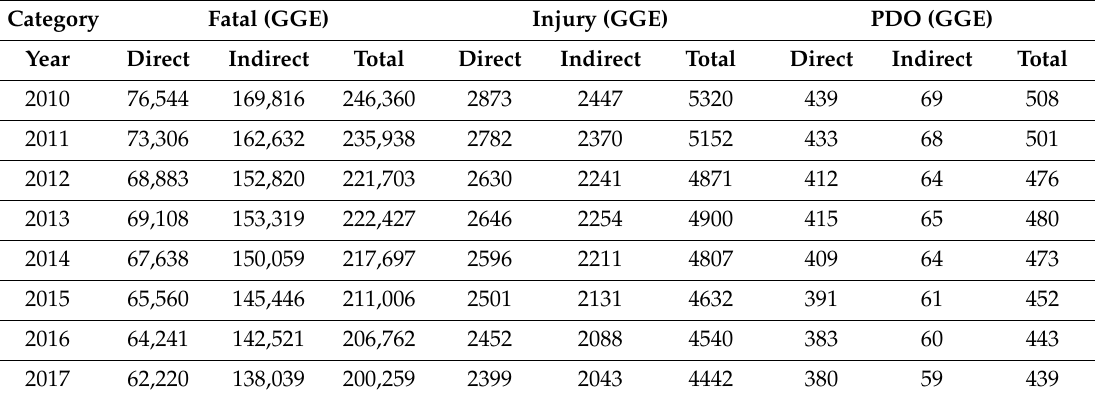
Table 6. Energy equivalence of safety (EES) per crash type.